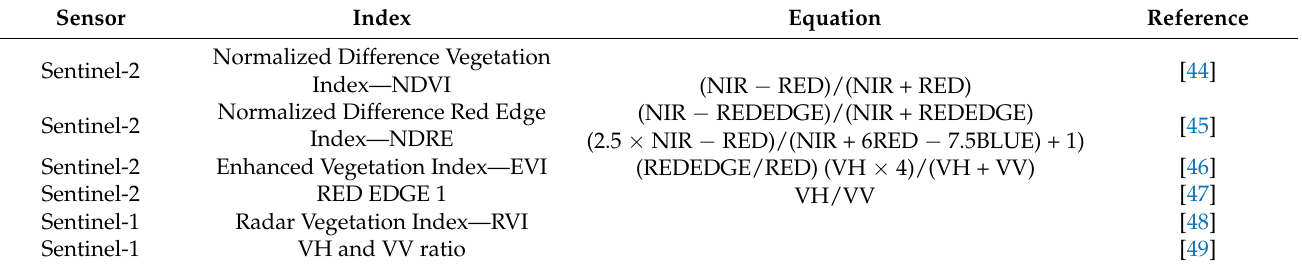
Table 1. Sentinel-1 and Sentinel-2 indexes